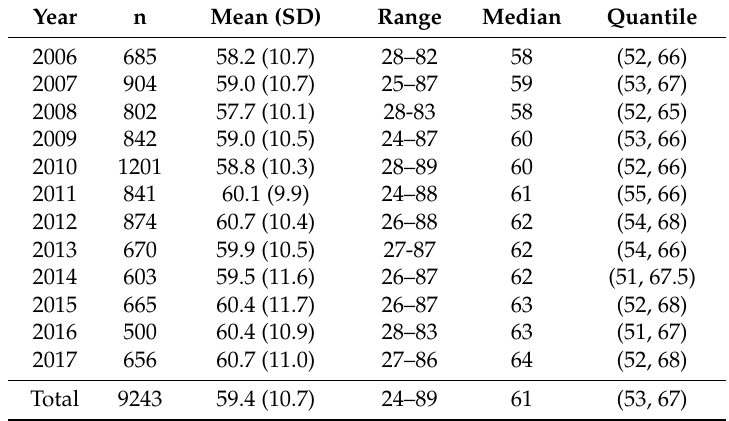
Table 5. The changing trend of the average diagnosis age of pneumoconiosis cases from 2006 to